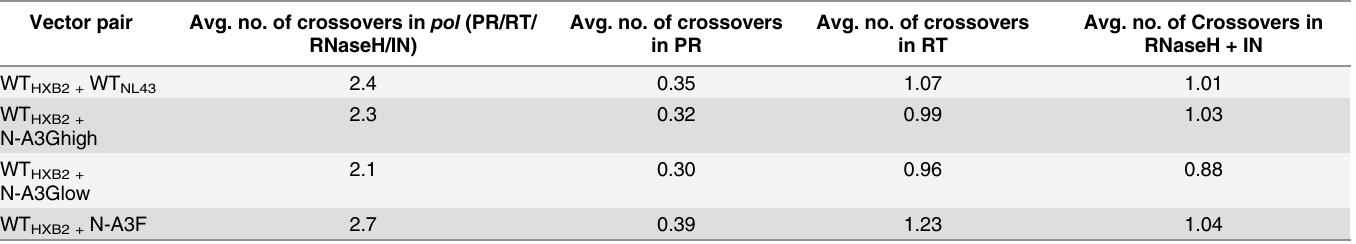
Table 2. Crossover analysis for recombinants throughout pol . Vector pair Avg. no. of crossovers in pol (PR/RT/